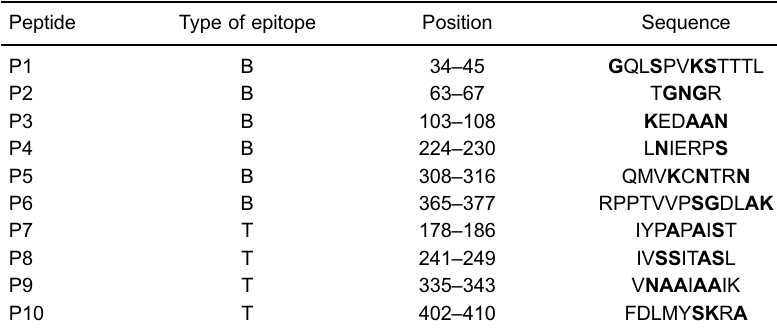
Table 3. Predicted B and T cell epitopes of Der f